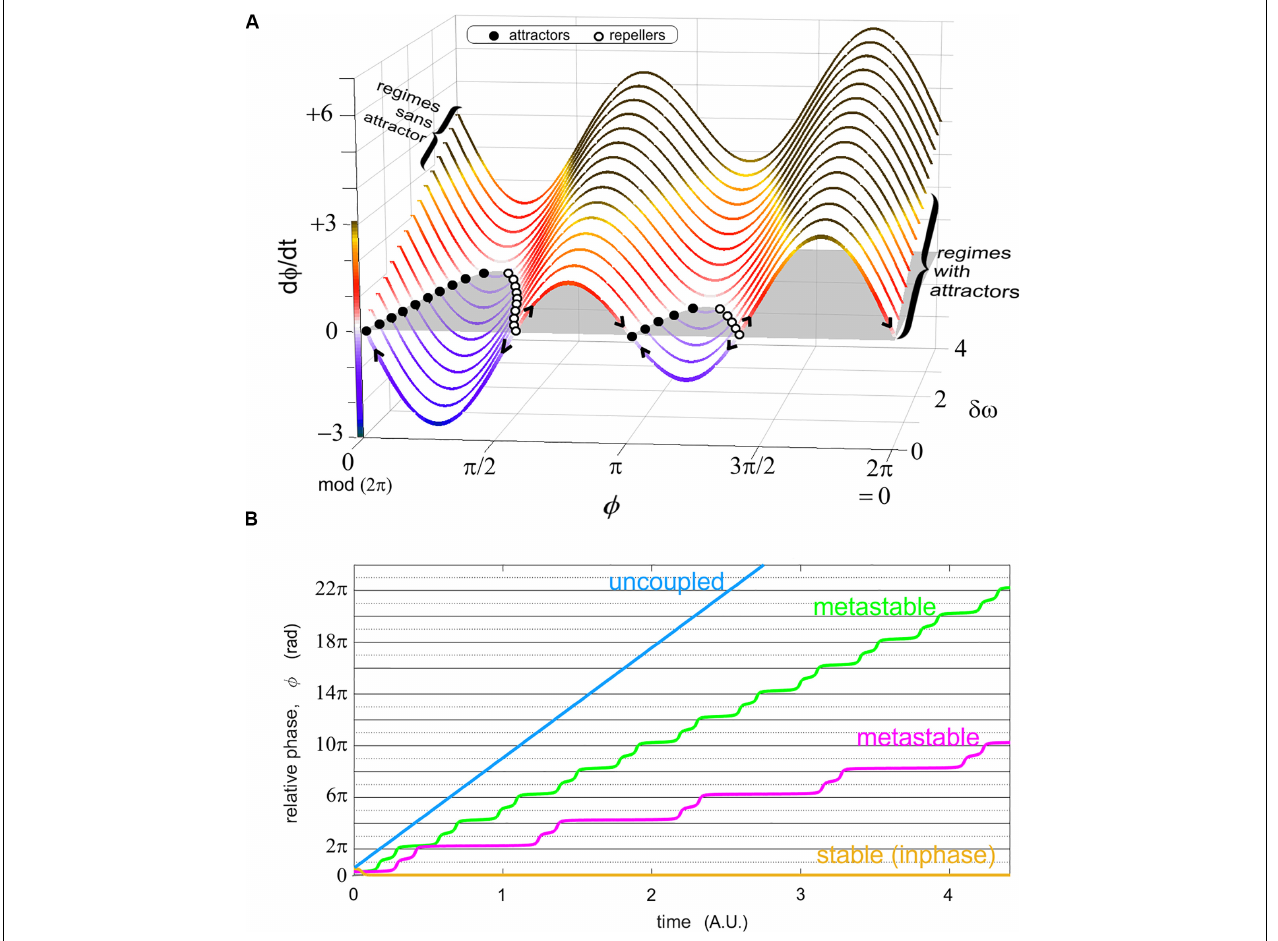
FIGURE 2 | Two representations of the relative phase as an order parameter connecting models and experiments. (A) shows the phase portrait of φ in the “extended” HKB model (Kelso et al., 1990) for various values of a diversity parameter δω . This graph carries regimes of coordination with attractors in the front of the figure (for modest diversity δω , shown; also when coupling is strong, not shown) and those without attractors (large diversity of the parts, shown in the back of the figure; and/or weak coupling, not shown). Attractors exist when the phase portrait (a function describing the rate of change of the relative phase as a function of itself) has values at d φ d t = 0 (i.e., the coordination does not change over time) and a converging flow (filled black dots attracting the flow as indicated by the arrows). Stable regimes reflect a sustained cooperation among the system’s parts, but this stability also leads to inflexibility (see Kelso and Tognoli, 2007 for more details). In (B) , four sample (unwrapped) relative phase evolutions over time illustrate stable coordination (yellow) where the order parameter φ persists at the same value (ad infinitum in models); metastability (magenta, green) with their characteristic dwells (quasi horizontal epochs, attracting tendencies near inphase, i.e., 0 rad. and antiphase, i.e., π rad. modulo 2 π ) and escape (wrapping); and uncoupled behavior (blue), whose relative phase grows continually with time (it approaches a linear function when the probability distribution of individual phases lacks remarkable joint phase